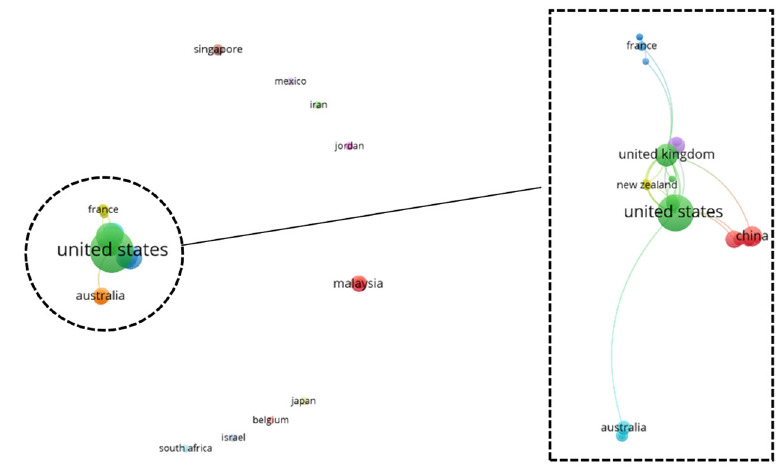
Figure 9. Geographical scientometric analysis of the included review works.